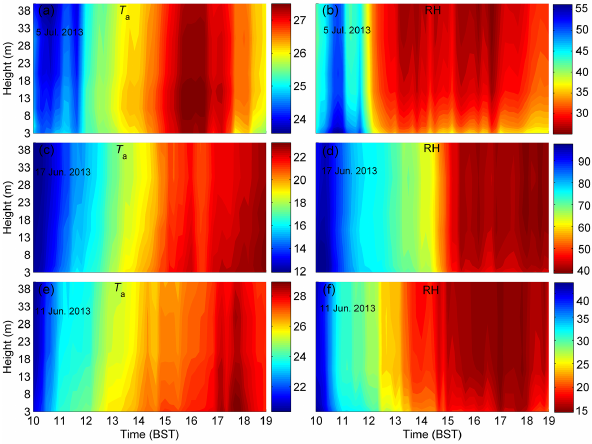
Figure 10. The diurnal evolutions of temperature ( T a ; ◦ C) and rela- tive humidity (RH; %) profiles from 3 to 40m above the ground on 5 July 2013 (a) . An obvious advection process can be detected from 13:00 to 17:00BST with high temperature and a low RH layer at the height of 8–18m on 17 June 2013 (b) . A precipitation event occurred at 13:00BST and resulted in uniform vertical distribu- tions of T a and RH, but no temperature inversion was observed on 11 June 2013 (c) . It represented a typical clear and advection-absent day.